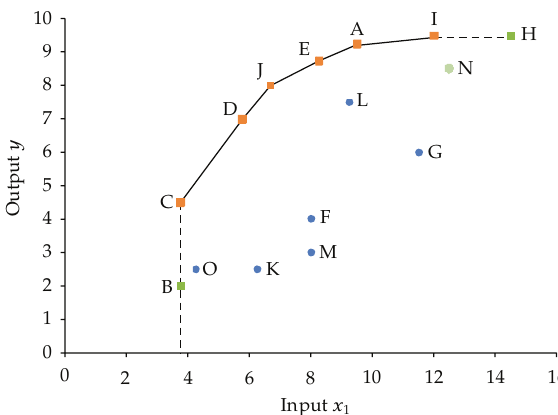
Figure 1: Single input single output case, VRS.